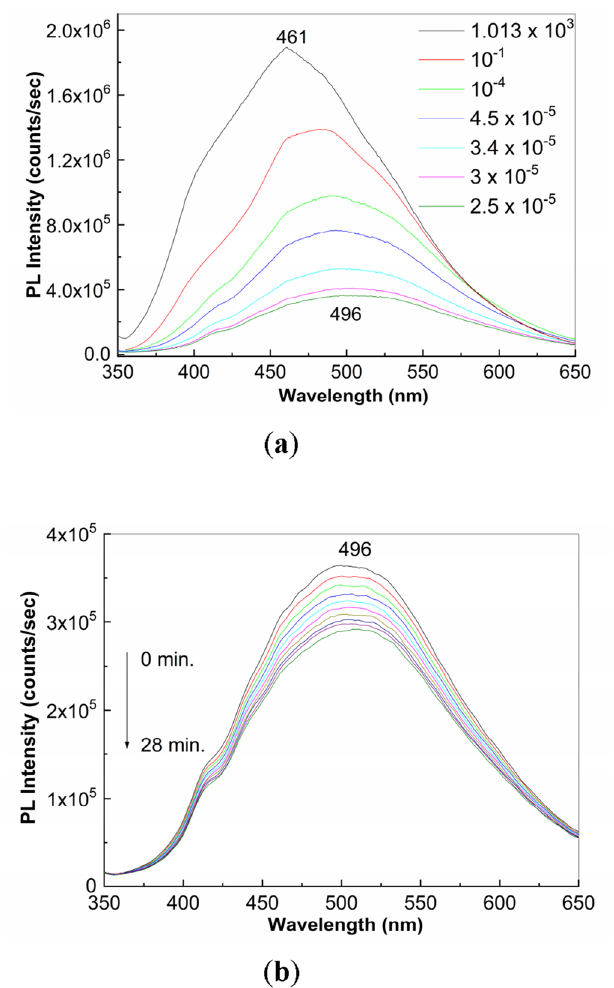
Figure 5. The dependence of the PL spectra of PS ( 1 ) depending on the pressure of environmental conditions ( a ) and the evolution of the PL spectra of PS ( 1 ) under vacuum conditions, when the pressure was equal to 2.5 × 10 –5 mbar and the sample was exposed to UV light, time of 28 min. ( b ). In Figure a , the black, red, green, blue, cyan, magenta and olive curves correspond to the PL spectra of PS when the sample is at a pressure equal to 1.013 × 10 3 mbar, 10 –1 mbar, 10 –4 mbar, 4.5 × 10 –5 mbar, 3.4 × 10 –5 mbar, 3 × 10 –5 mbar and 2.5 × 10 –5 mbar, respectively. In Figure b , the black, red, green, blue, cyan, magenta, dark yellow, navy, purple and olive curves correspond to the exposure times of PS to UV light equal to 164 s, 328 s., 492 s, 656 s, 820 s, 984 s, 1148 s, 1312 s, 1476 s and 1680